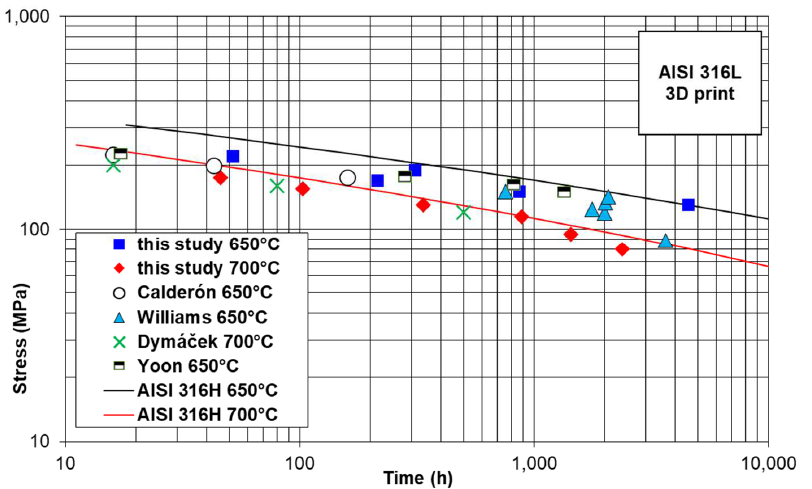
Figure 16. Comparison of stress–time to rupture dependence for 3D-printed steel 316L, lines represent the mean CRS of AISI 316H steel.